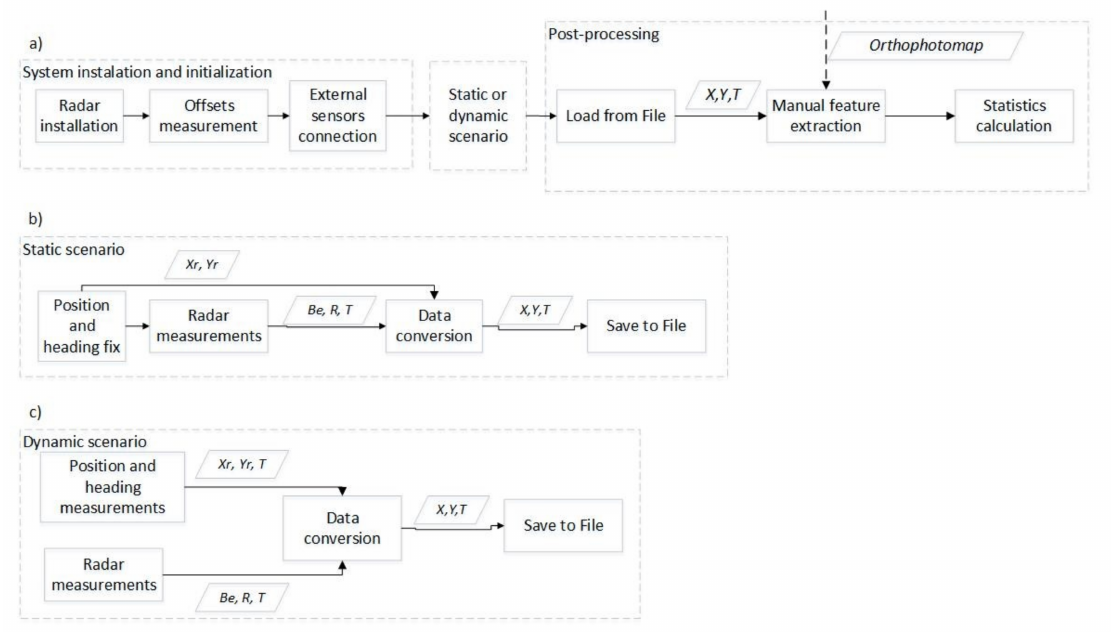
Figure 4. Scheme for radar